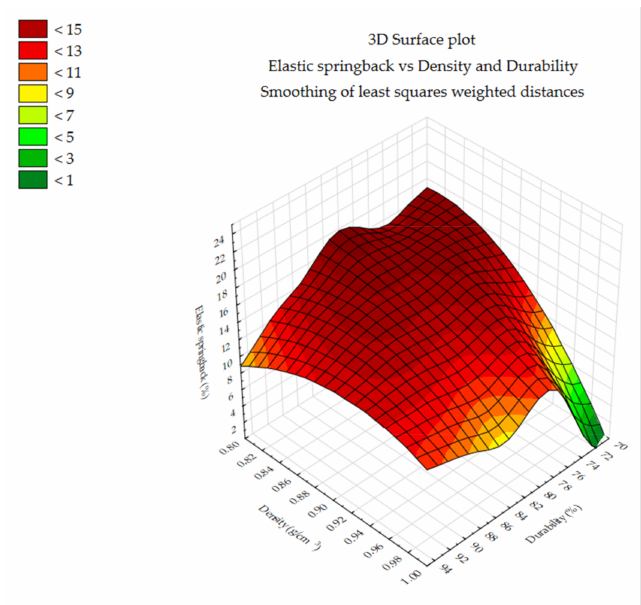
Figure 9. Elastic springback vs. density and durability—silphium. Correlation analysis was performed for two variants—density (g/cm 3 ) vs. elastic springback and durability vs. elastic springback. Figure 11 plots the correlation values of elastic springback vs. density and elastic springback vs. durability. In the cases of miscanthus and silphium, it can be seen that elastic springback is correlated with density (correlation coefficient miscanthus—r = 0.9433 and silphium—r = 0.9447). This means